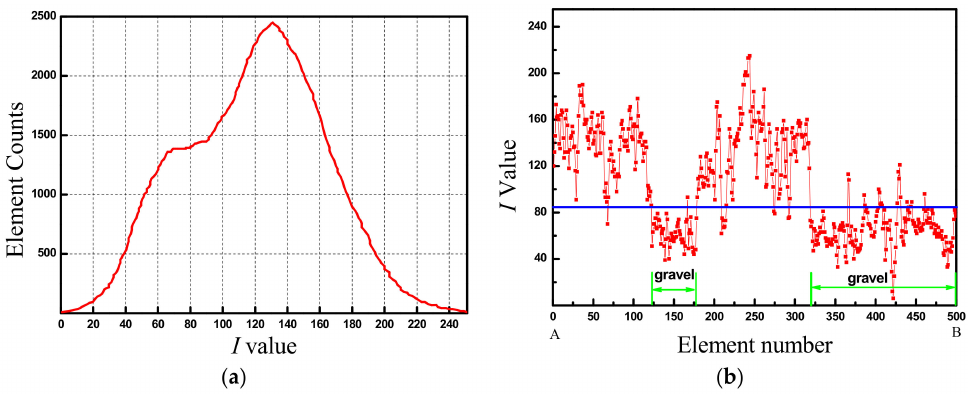
Figure 4. Elements color information provided by rock failure process analysis (RFPA). ( a ) Statistical element counts with different I values; ( b ) I values of elements along A–B.